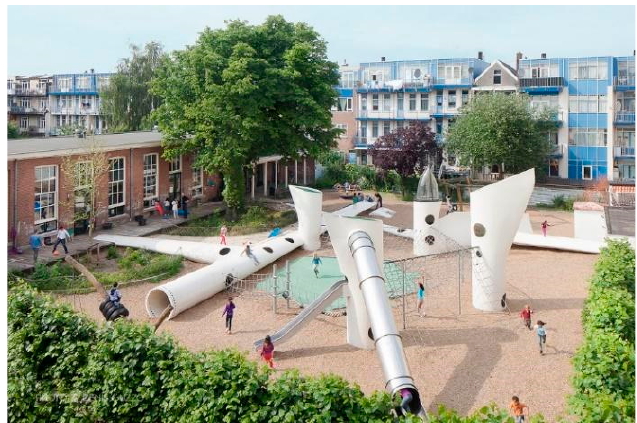
Figure A6. Wikado playground [48].